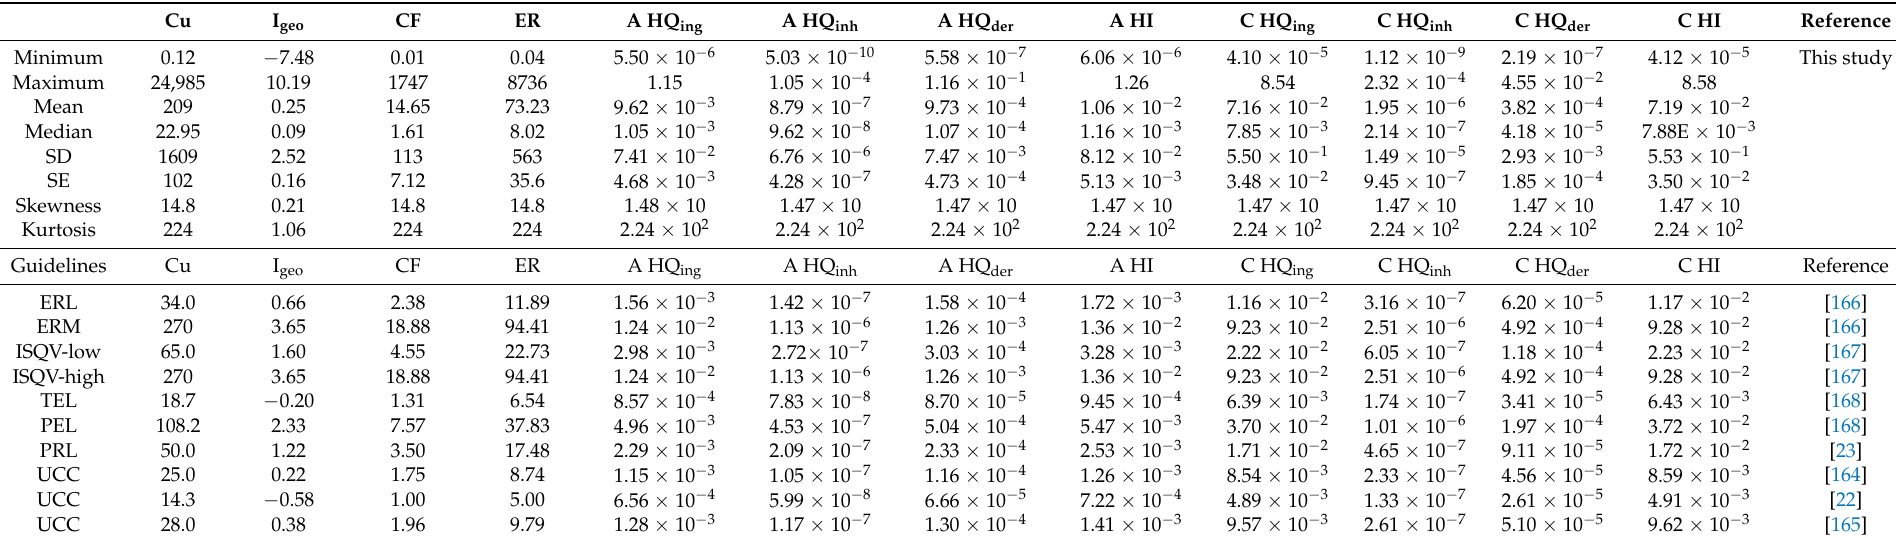
Table 3. Comparison of the overall statistics of the Cu calculated values of the geoaccumulation index (I geo ), contamination factor (CF), and ecological risk (ER), hazard quotient ingestion (HQ ing ), hazard quotient inhalation (HQ inh ), hazard quotient dermal contact (HQ der ), hazard index (HI) for adults (A) and children (C) based on the Cu concentrations ranges (mg/kg dry weight) (minimum and maximum) in the sediments cited from 125 papers in the literature published between 1980 and 2022 with the different established guidelines